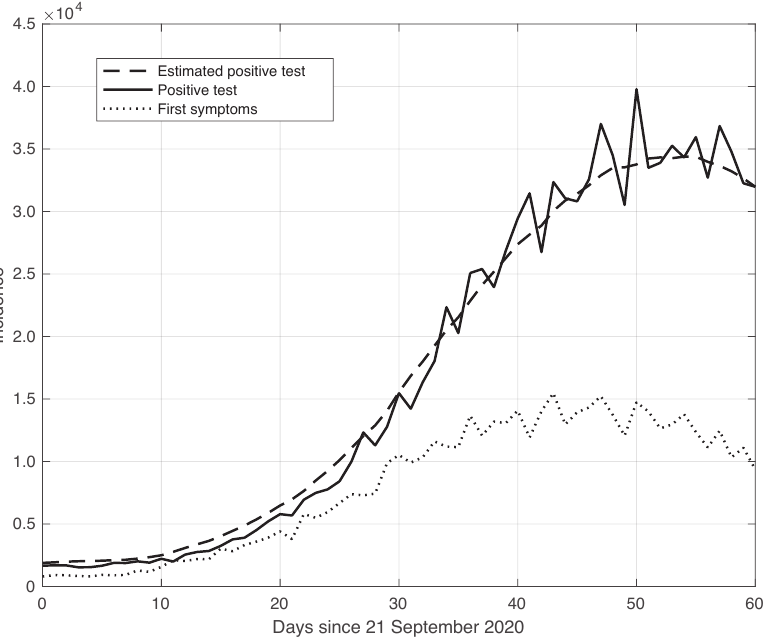
Figure 4. Relationship between the sequences of the positive test (continuous line) and the first symptoms (dotted line) relative to the real SARS-CoV-2 Italian data from 21 September to 20 Novem- ber 2020, illustrated in Figure 1. The curves were obtained by correcting the data from a one-week periodic component (see Section 2.2). The dashed line shows the results of the convolution between the first symptoms sequence and the optimal kernel (see Section